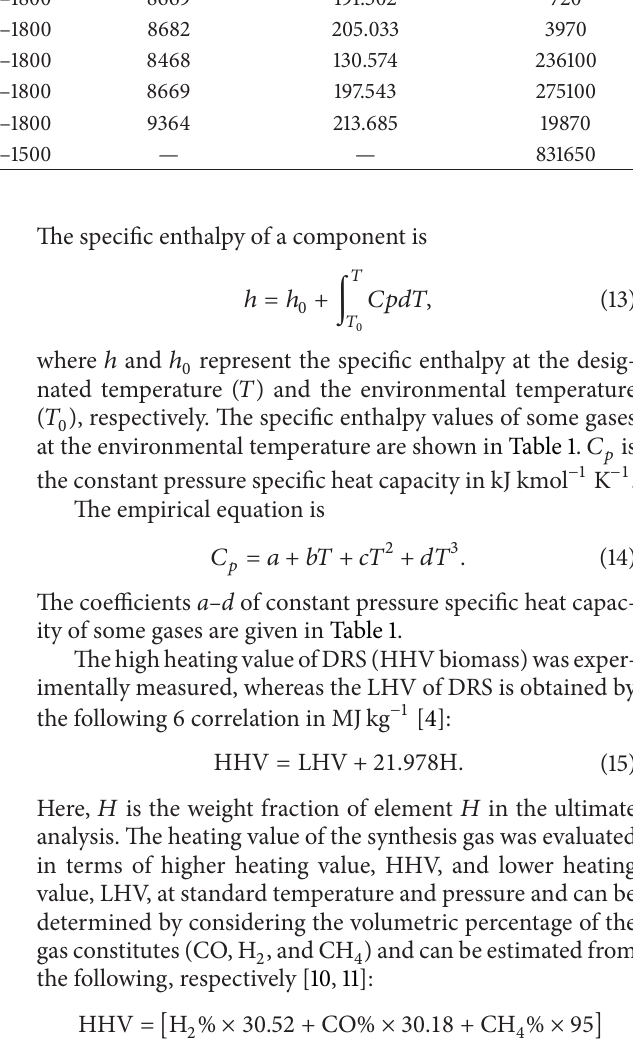
Table 1: The coefficients 𝑎 – 𝑑 of constant pressure, specific enthalpy and entropy at 𝑇 0 , and standard chemical exergy of gases.